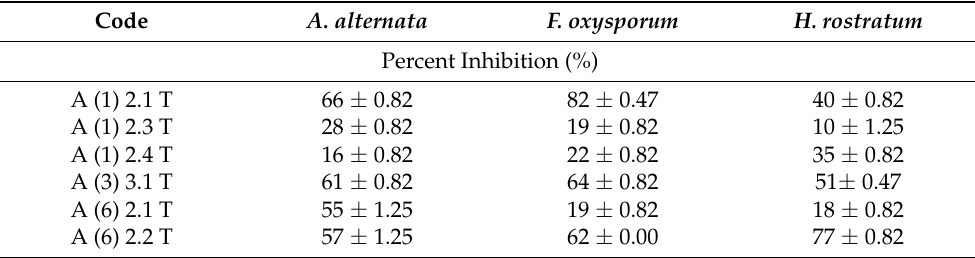
Table 3. Antagonistic activity of Trichoderma spp. against A. alternata , F. oxysporum , and H. rostratum evaluated by dual culture interaction. Code A. alternata F. oxysporum H. rostratum